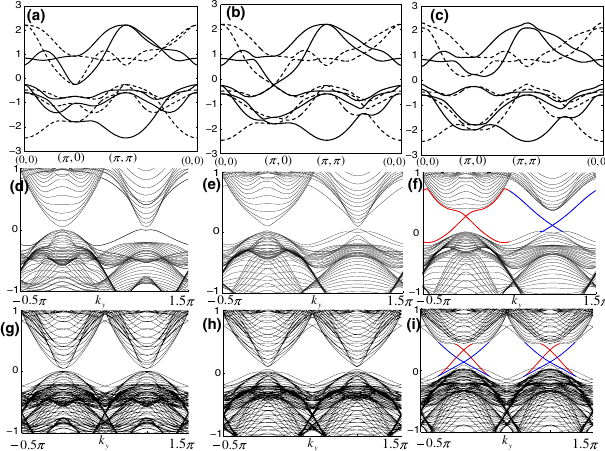
FIG. 3. (a) – (c) The spectrum along high-symmetry lines for different SOC parameters with (a) λ o ⊥ ¼ 0 , λ nn ⊥ ¼ 0 , (b) λ o ⊥ ¼ 0 . 32 , λ nn ⊥ ¼ 0 . 08 , and (c) λ o ⊥ ¼ 0 . 5 , λ nn ⊥ ¼ 0 . 12 . Other parameters λ o ∥ and ξ are set to zero. (d) – (f) [(g) – (i)] are the s corresponding one-Fe unit-cell (two-Fe unit-cell) edge spectrum with open boundary along the x direction. The width of the single-layer film is 21 in units of the lattice